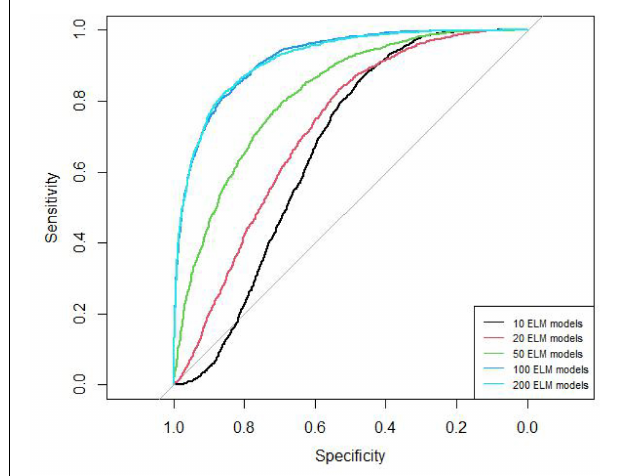
FIGURE 2 | ROC curves of different ELM model number.